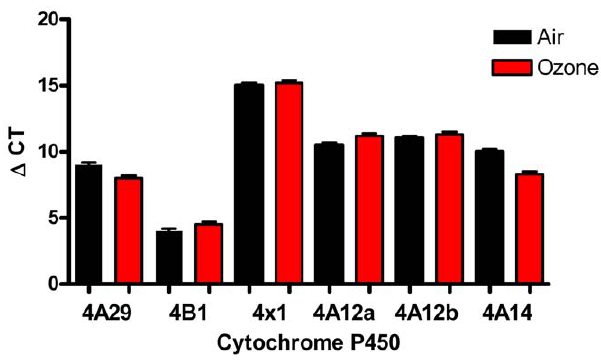
Figure 5. Ozone did not increase CYP enzymes measured. mRNA was extracted from whole lungs of mice exposed to ozone (6 ppm; 2 h; T=0 h) and CYP isotypes were quantified using Taq Man qPCR, as described in the methods. Data was run in triplicate and expressed as mean 6 SEM (n=5 in each group).